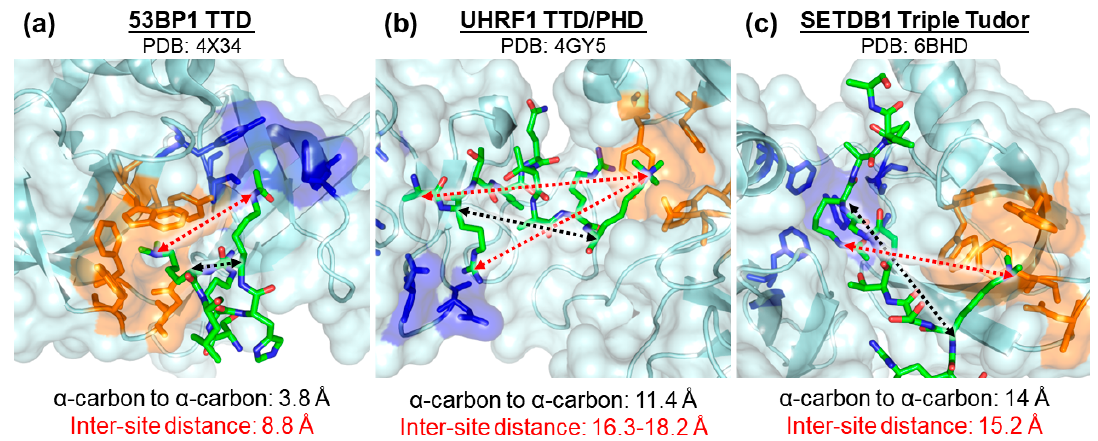
Figure 2. Close-up view showing basic dimensions and spatial features for multivalent Kme reader: peptide interactions of proteins ( a ) 53BP1 (PDB: 4X34), ( b ) UHRF1 (PDB: 4GY5), and ( c ) SETDB1 (PDB: 6BHD). The regions highlighted in orange of each panel are the methyl-lysine binding pockets and the regions highlighted in blue are the ancillary binding pockets. The distances between the α -carbon of each PTM residue and the inter-site distances are depicted using black and red arrows, respectively.